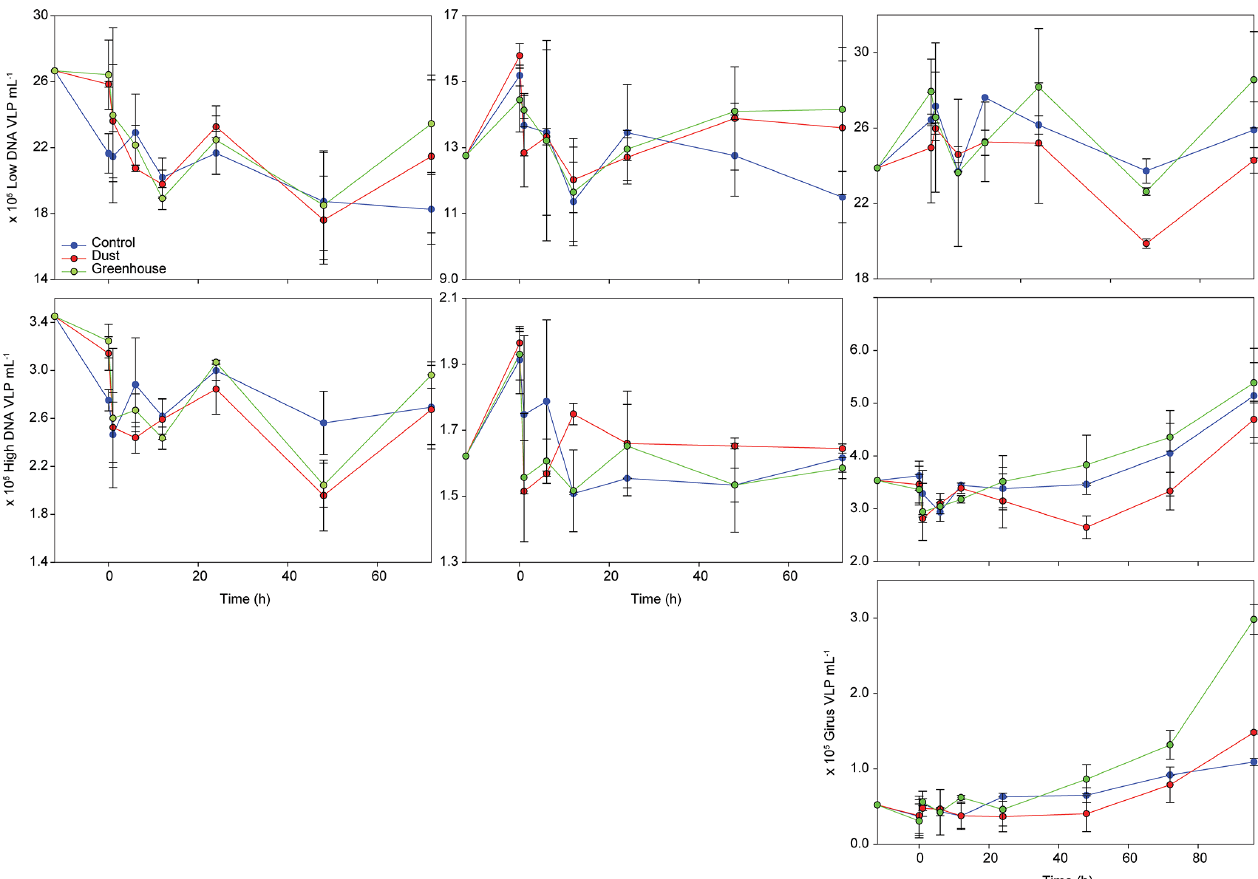
Figure 4. Evolution of virus-like particle (VLP) abundances of three different viral populations over the course of the three experiments (TYR, ION, and FAST). The first row represents low DNA viruses or phages, the second row represents high DNA viruses, and the third row represents giant viruses